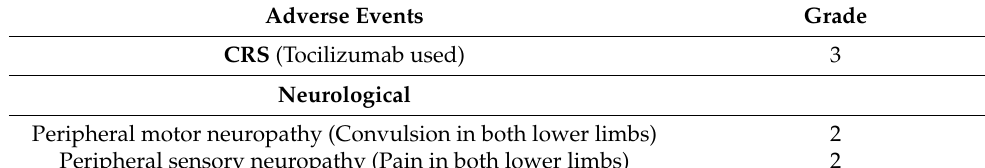
Table 1. Detailed adverse events of the patient. Adverse Events Grade CRS (Tocilizumab used) 3 Neurological Peripheral motor neuropathy (Convulsion in both lower limbs) 2 Peripheral sensory neuropathy (Pain in both lower limbs) 2 Hematological Anemia 3 Thrombocytopenia 2 Febrile neutropenia 3 Infectious Enterocolitis infectious (Fungal enteritis) 3 Cytomegalovirus infection reactivation (CMV retinitis) 3 Mucositis oral (Ulcerations) 3 Lung infection 3 Others Alanine aminotransferase increased